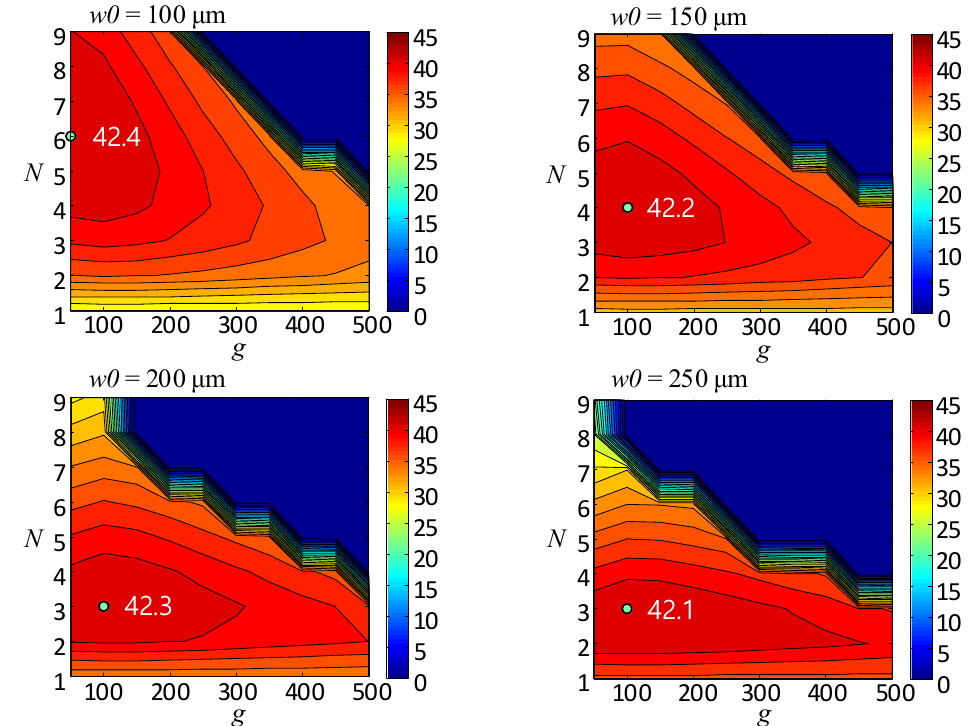
Figure 12. The calculated maximum coupling efficiency (%) according to g and N for the double-layer planar spiral coils for w 0 = 100, 150, 200, and 250 μ m.